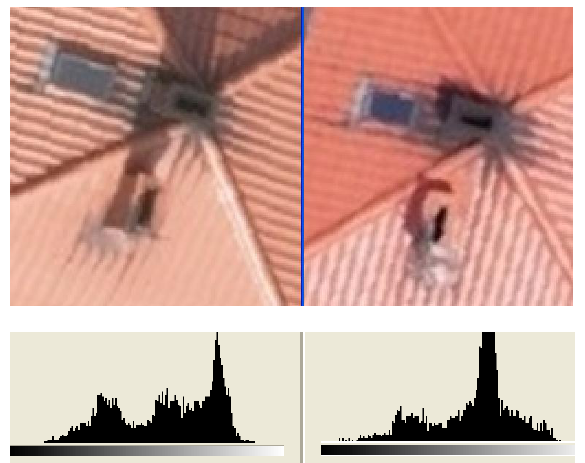
Figure 9. The part of one image – classic (left) and UAV (right) and their histograms